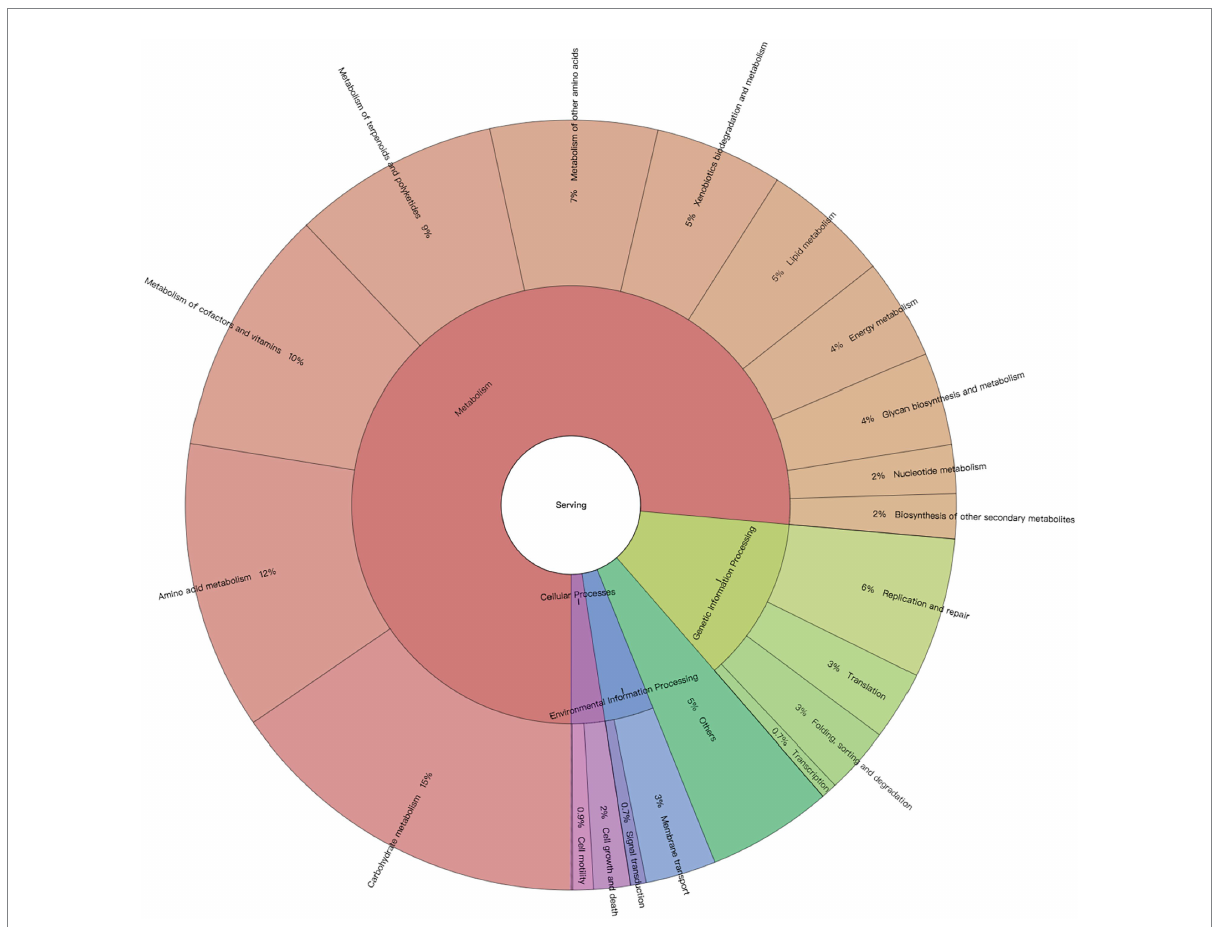
FIGURE 1 Profiles of neonatal calves’ colon microbiome. Microbial metabolic pathways based on their First and Second Level functions in the KEGG